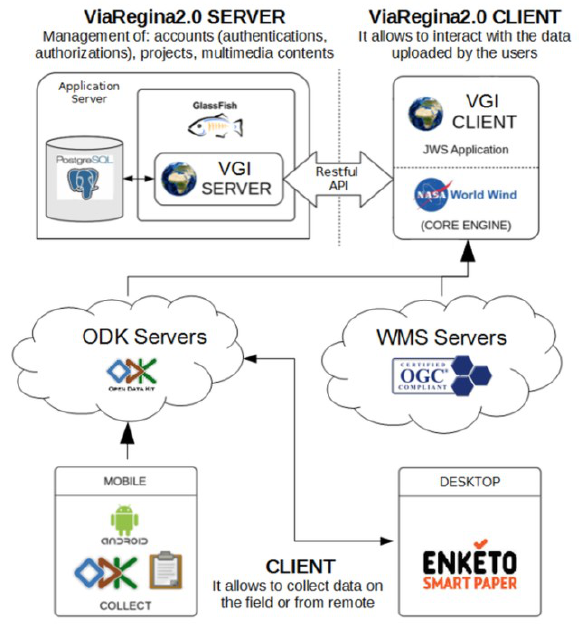
Figure 3. System architecture of ViaRegina2.0